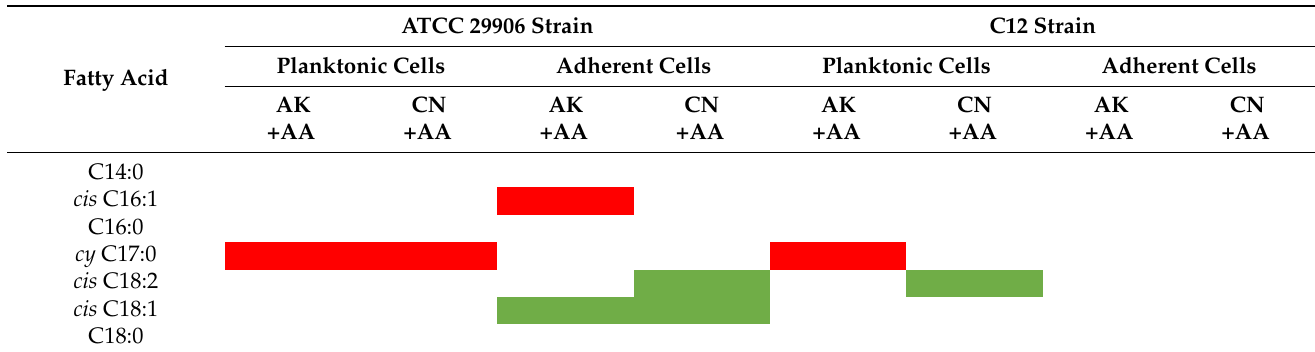
Table 5. Statistically significant changes in the FA levels induced by combined treatment with ascorbic acid and amikacin or gentamicin in the planktonic and adherent cells of the P. mirabilis strains, determined by Fisher’s test. ATCC 29906 Strain C12 Strain Planktonic Cells Adherent Cells Planktonic Cells Adherent Cells